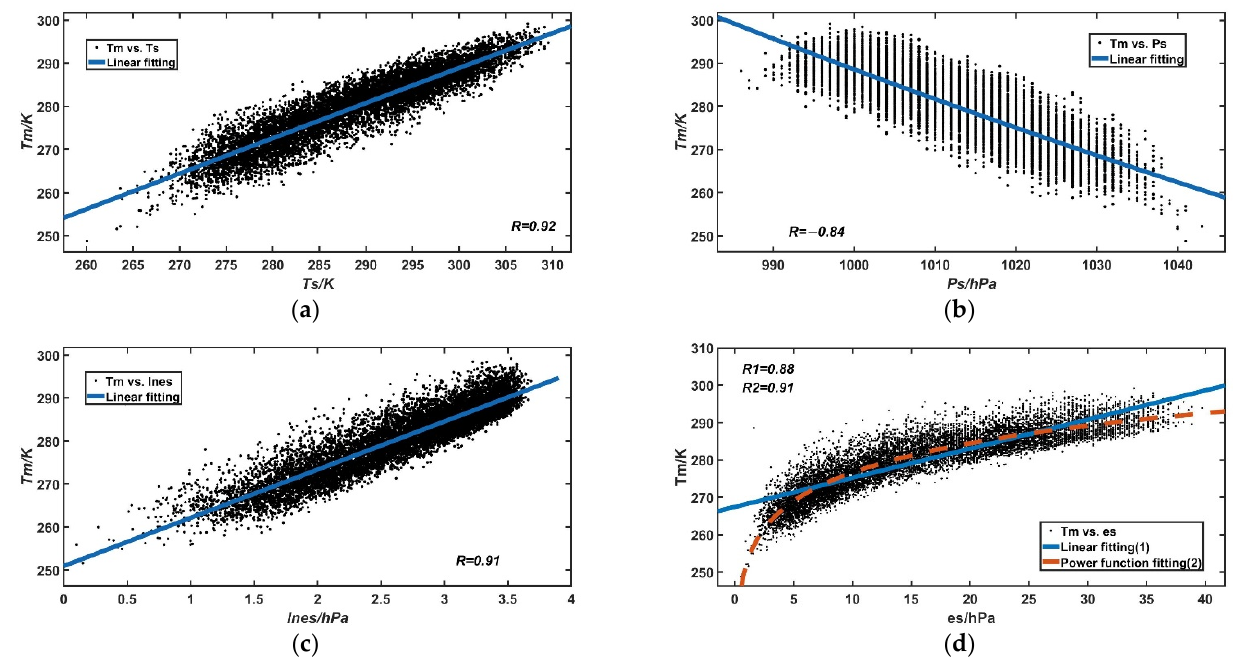
Figure 2. The correlation analysis between T m and T s ( a ) , p s ( b ) , ln e s ( c ) , e s ( d ) . Table 3. Statistics of linear correlation analysis.